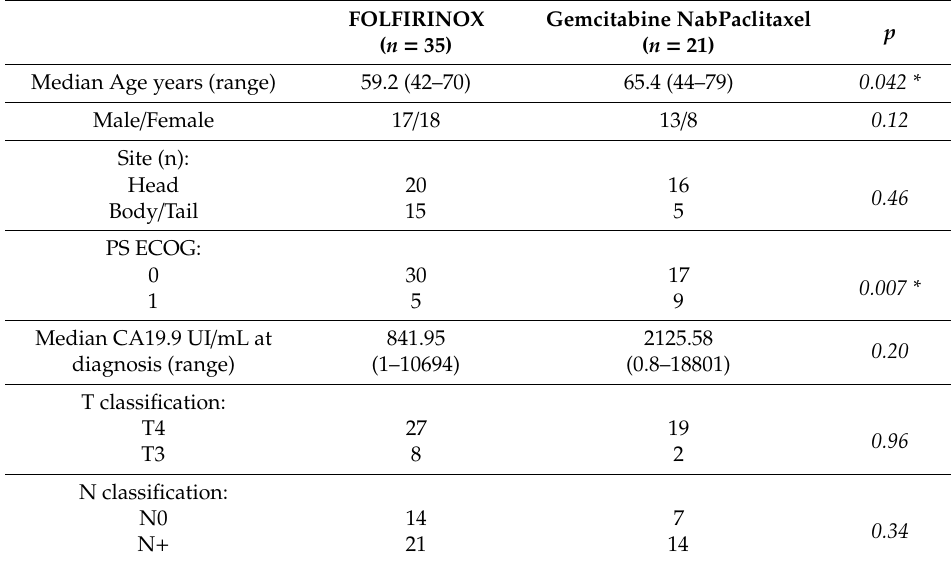
Table 1 shoes the demographic and disease characteristics of the patients at baseline. The populations were similar in the two treatment groups, except in the FFN treatment group age (59.2 years versus 65.4; p = 0.042) and PS ECOG ( p = 0.007) were both statistically significantly lower. Table 1. Characteristics of the patients at the baseline. * indicates statistically significant p values.